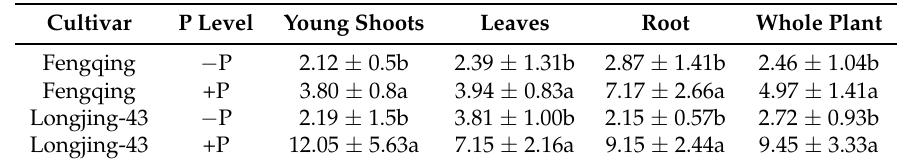
Concentrations of phosphorus (mg · g − 1 ) in plants supplied with two P levels in nutrient solutions. Cultivar P Level Young Shoots Leaves Root Whole Plant